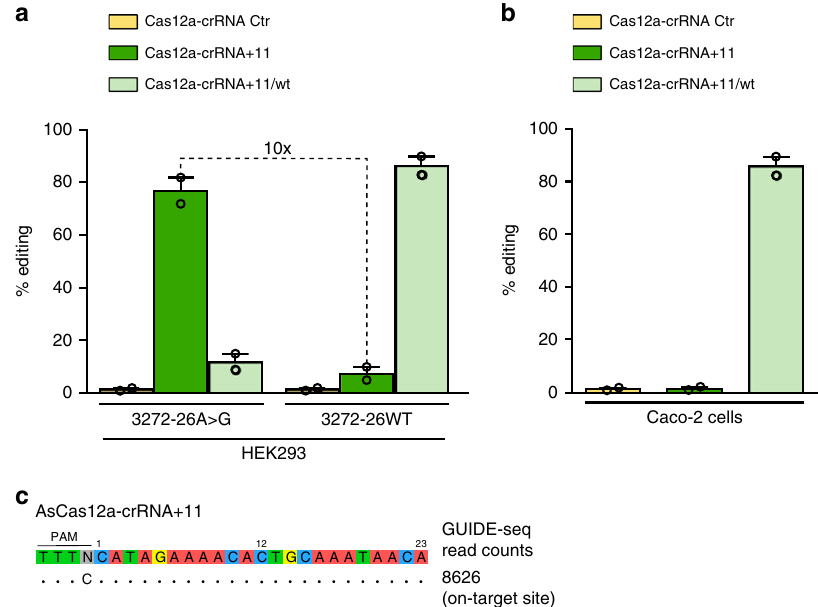
Fig. 2 Target speci fi city of AsCas12a-crRNA + 11. a , b Editing ef fi ciency by TIDE analysis in HEK293/pMG3272-26WT or HEK293/pMG3272-26A>G a and in Caco-2 cells b following lentiviral transduction of AsCas12a-crRNA + 11 or + 11/wt, as indicated. Data are means ± SEM from n = 2 independent experiments. c GUIDE-seq analysis of crRNA +